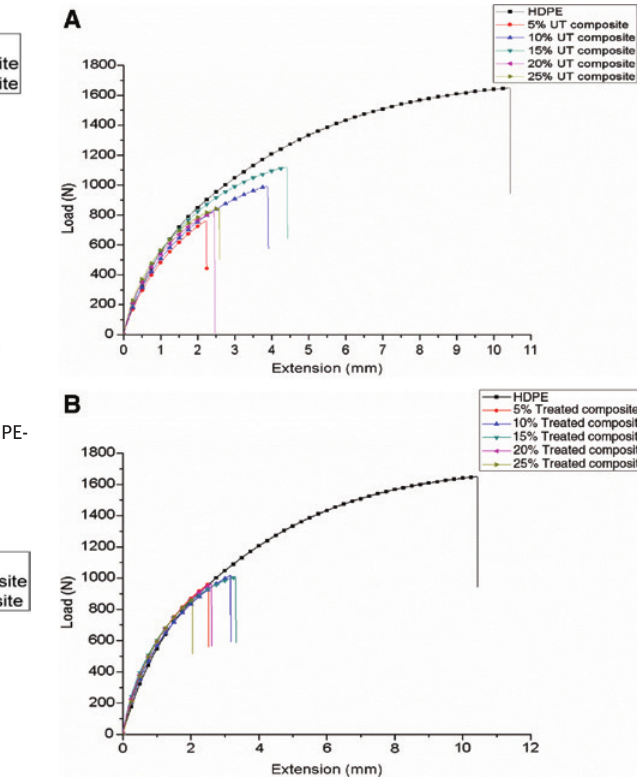
Figure 7: (A) Effect of fiber loading on applied load vs. extension of untreated HF/HDPE-reinforced composites and (B) effect of fiber loading on applied load vs. extension of alkali-treated HF/HDPE- reinforced composites.